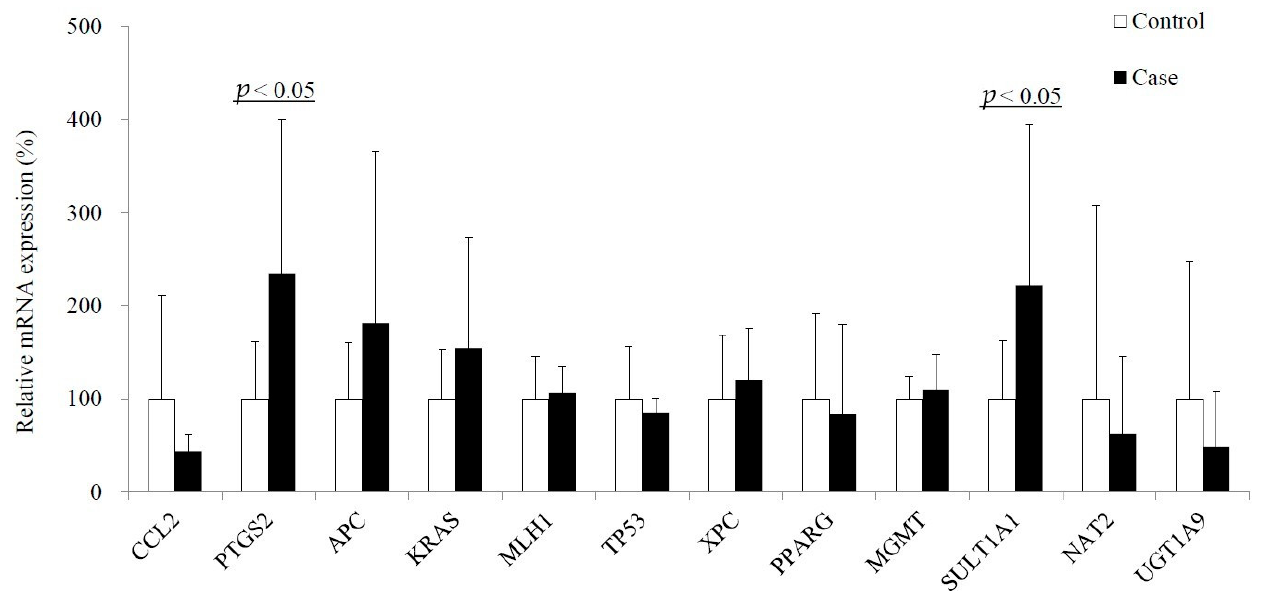
Figure 1. Comparison of expression of CRC-related genes: All data were normalized by reference gene RPLP0 .